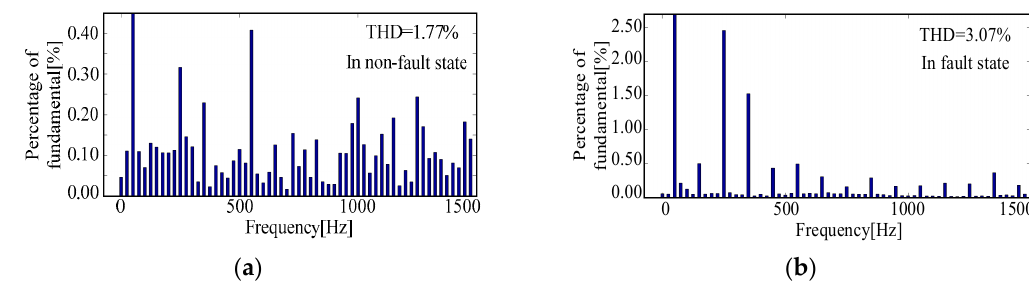
Figure 11. The simulated waveforms of THD for i a .